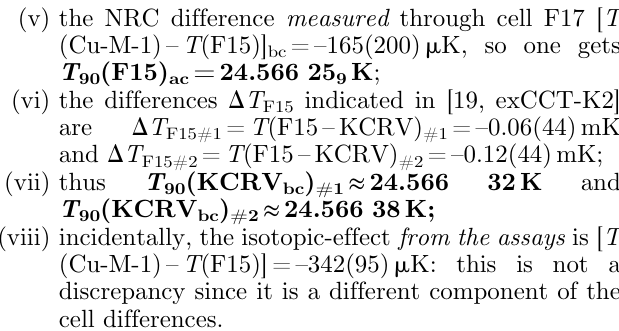
Fig. 1. Graphical representation of the procedure described in Section 2.1.1 for set #1.The procedure starts from cell NRC Cu- M-1, step (i), where T ref = T 90,Ne = 24.5561K. For the KCRV ac see Table 3 and Figure 2 The KCRV ac is 24.56647